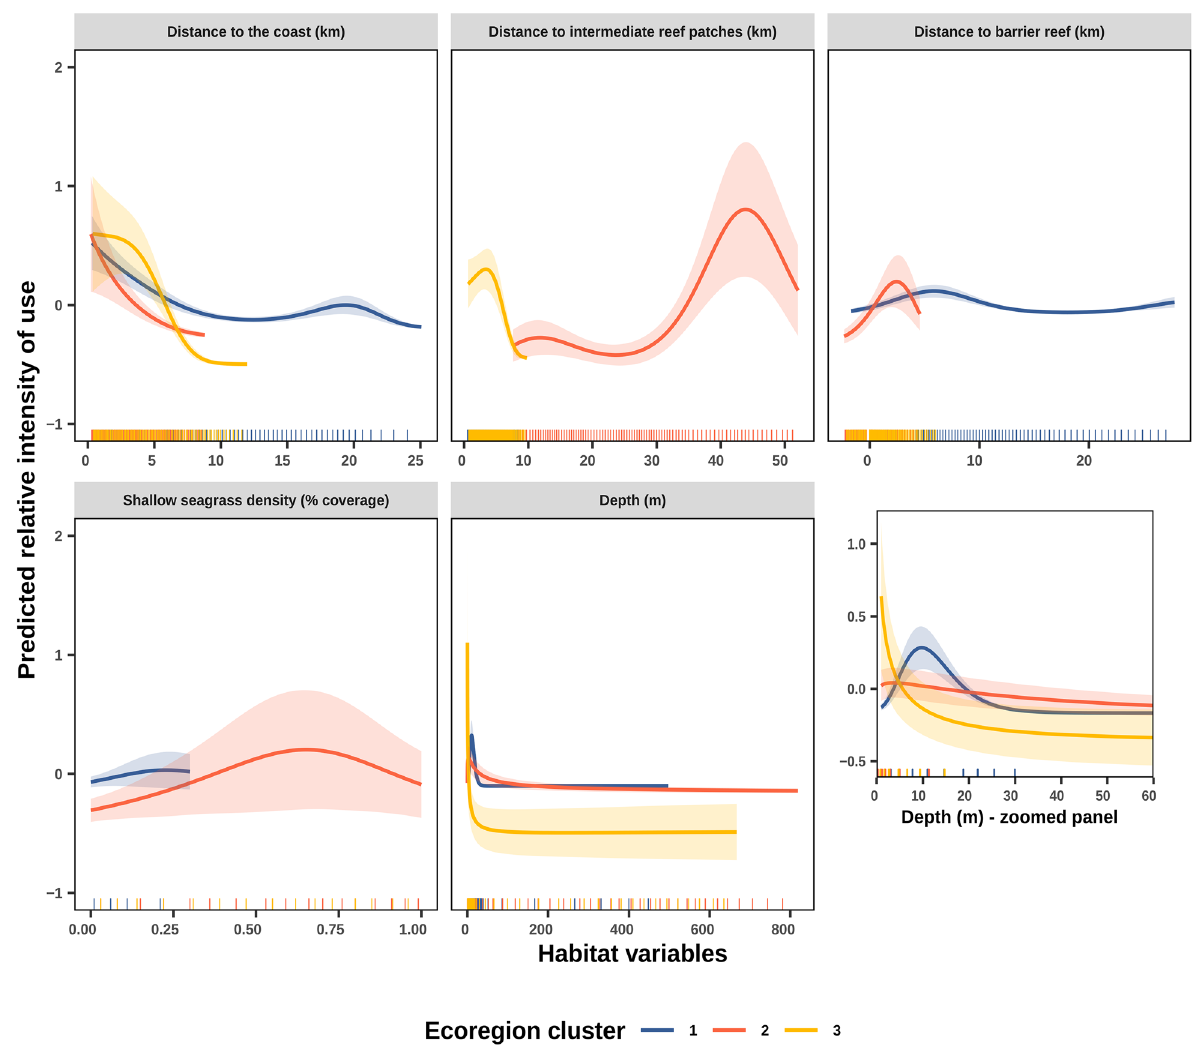
Figure 3. Partial response plots from a Generalized Additive Model between dugong habitat intensity of use and five environmental predictors (and a zoomed panel on response to depth in shallow-medium waters). The y-axis indicates the effect of the smooth function of each predictor upon the trend in dugong intensity of use, with higher values indicating increased intensity of use and potential for Area Restricted Search (predicted values were normalized to be centered on zero). Ecoregional smooth estimates are shown with different colors. Solid lines represent the marginal effect of each significant variable (with p value < 0.05) relative to dugong intensity of use. Shaded areas represent approximate 95% confidence intervals. Rug plots show the distribution of values per ecoregion for each predictor, with the 5% most extreme values being cropped out of the